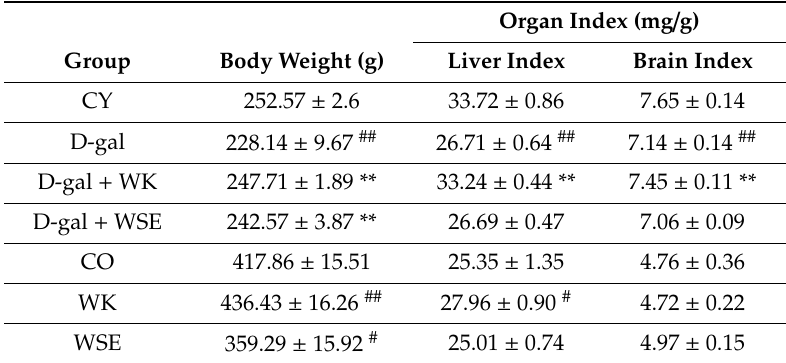
Table 2. E ff ects on body weight and organ index in D-gal-induced aging and naturally aged rats.